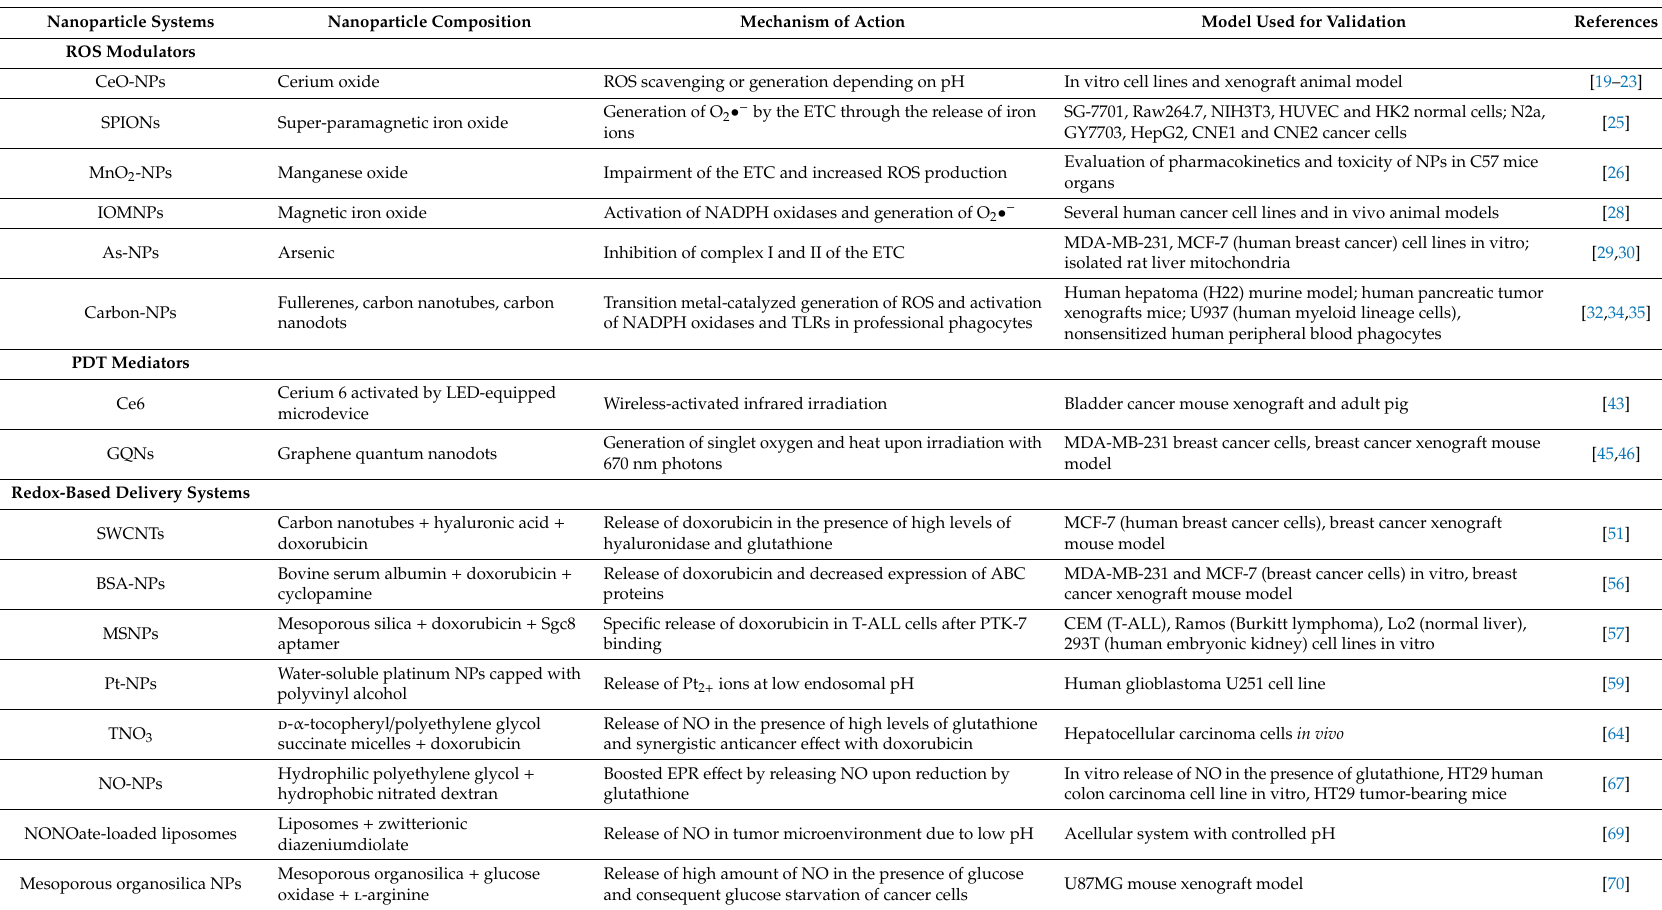
Table 1. Summary of the di ff erent types of NPs described in the